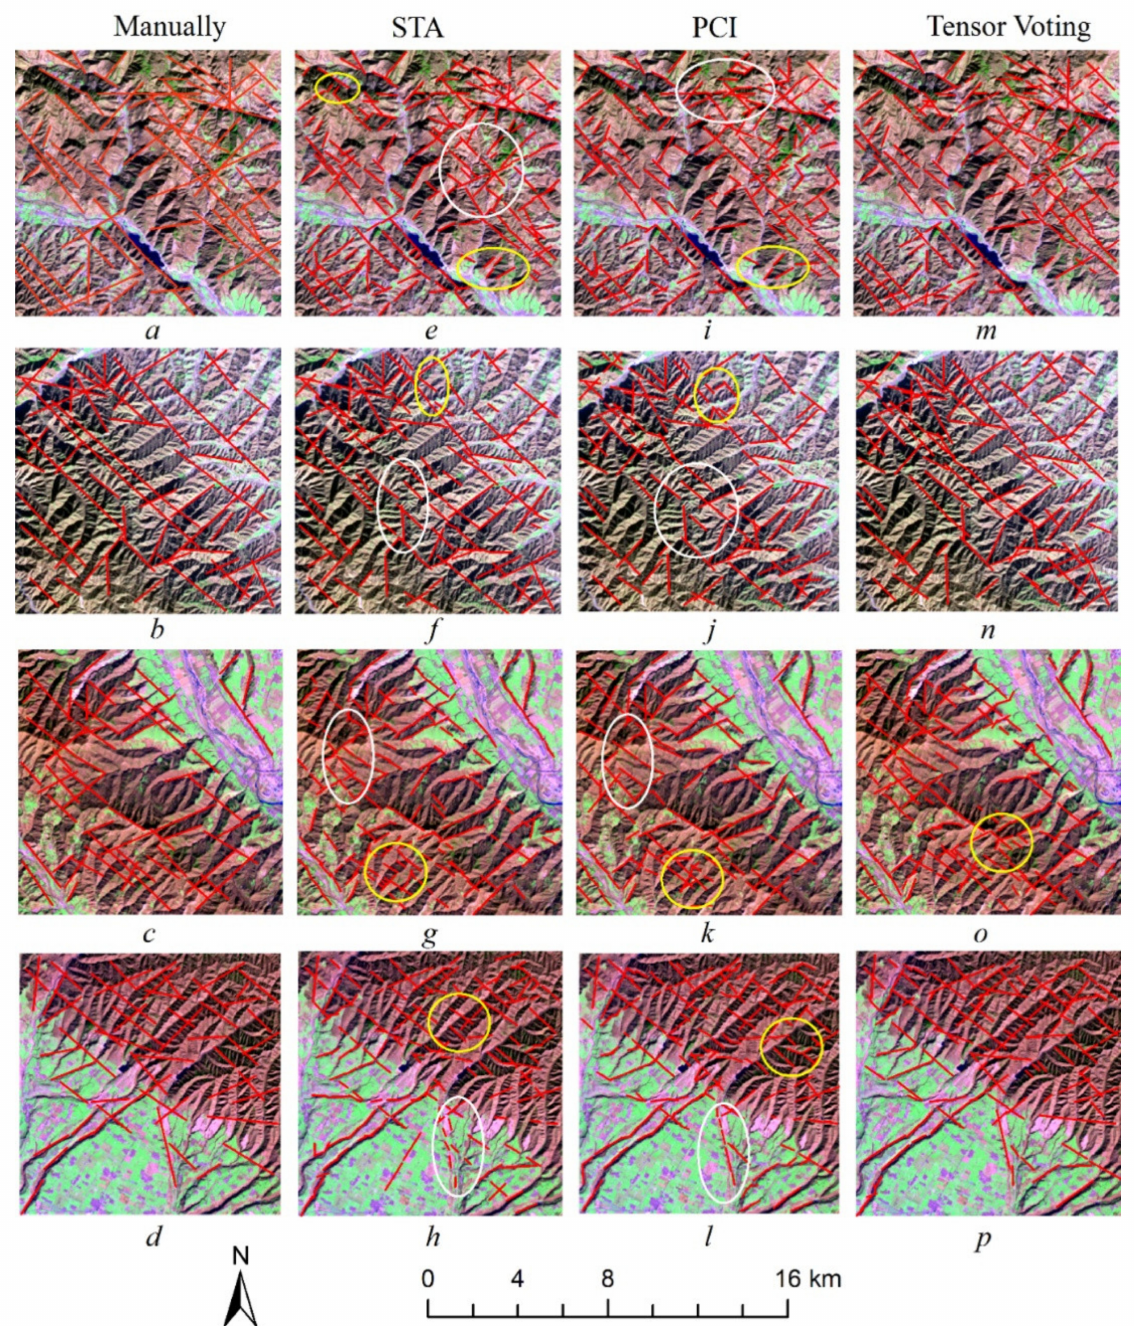
Figure 3. Comparison of extracted lineaments using different algorithms. ( a – d ) were selected from Figure 1, and the base map is the 7-5-2 band composite image. ( e – h ) are the lineaments extracted from the STA. ( i – l ) are the lineaments extracted from the PCI. ( m – p ) are the lineaments extracted from the Tensor Voting. Red lines are lineaments, yellow regions are false edge areas, and white ellipses represent the continuity feature from the